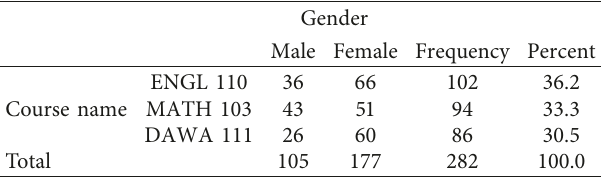
Table 2: Descriptive statistics by course and